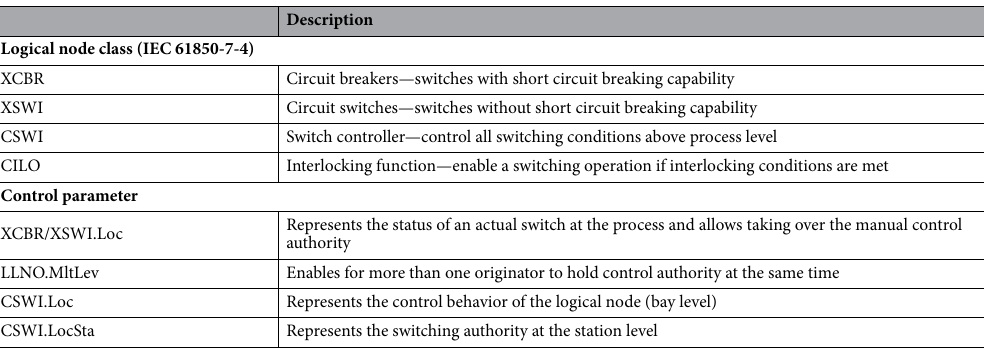
Table 2. Logical node classes and control parameters as per IEC-61850 6 .